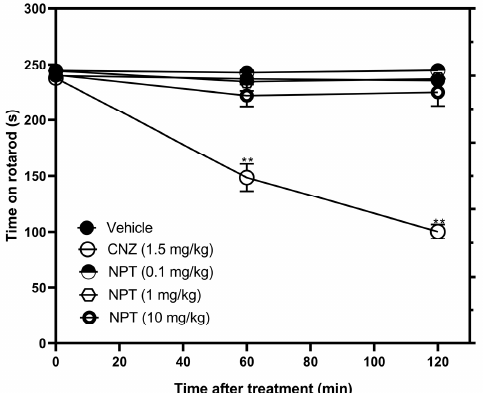
Figure 8. Locomotor actions of NPT. Effects of NPT (0.1–10 mg/kg p.o.) on time on rotarod were measured. Clonazepam (CNZ) was the anxiolytic drug at 1.5 mg/kg p.o. The results of all experi- mental groups are reported as the mean values ( ± SEM). n = 8, ** p < 0.05 regarding to the vehicle group (indicated as V).